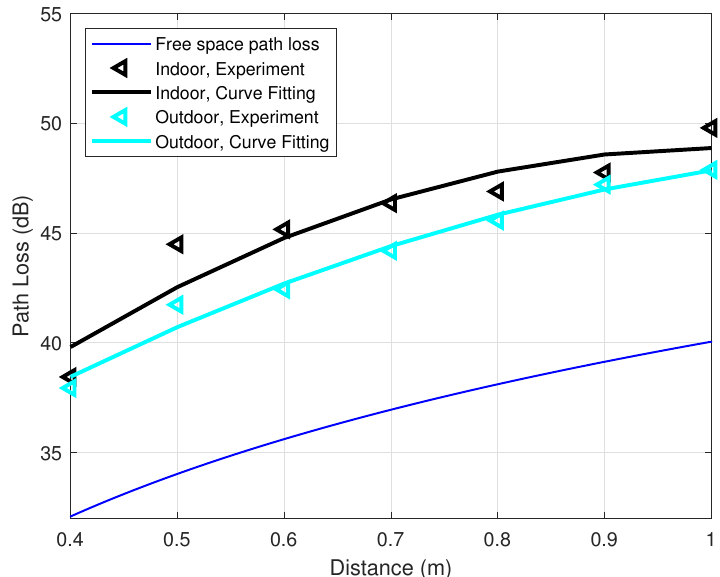
Figure 9. Indoor and outdoor comparison of path loss at transmitted power P 0 = 0 dBm, 9600